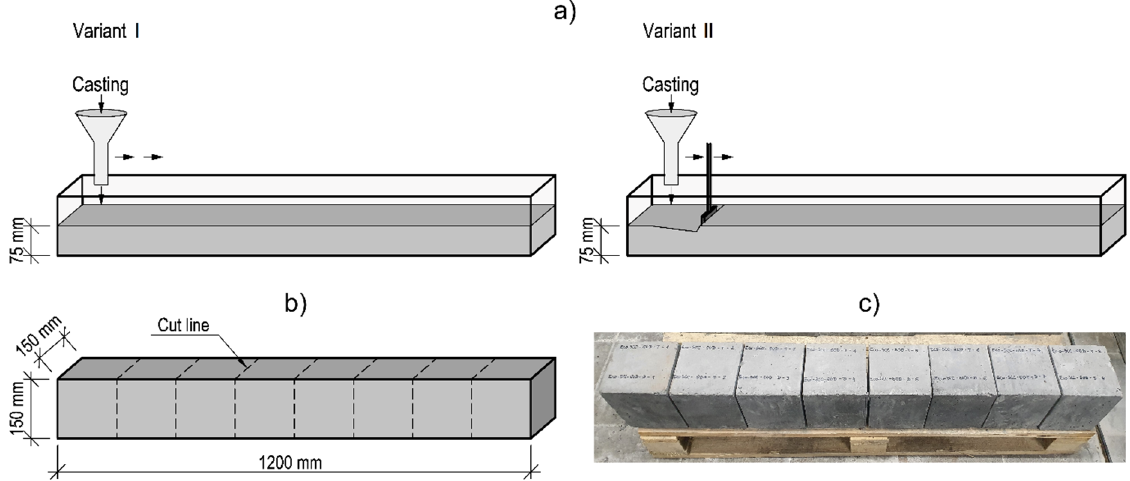
Figure 1. Specimens used: ( a ) a schematic view of surface preparation variants in multilayer casting; ( b ) a schematic view of a test element; ( c ) a test element cut into modules.